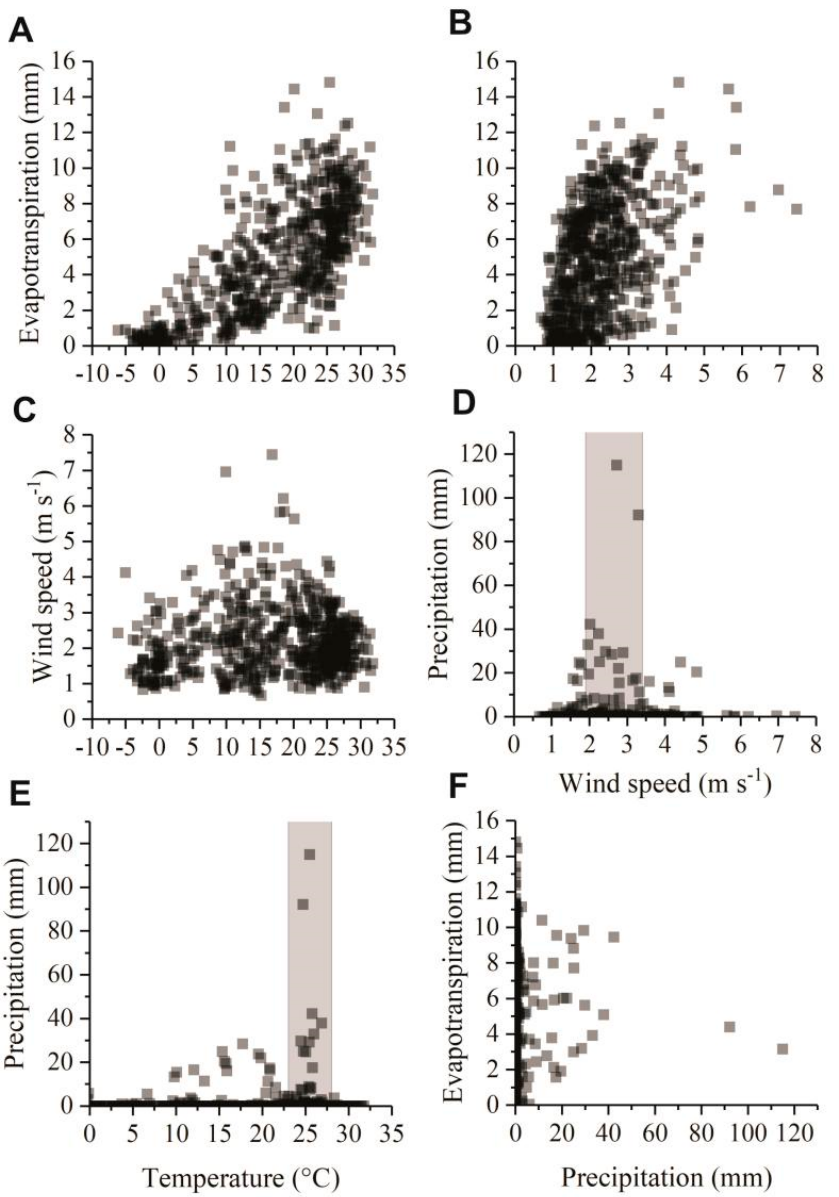
Figure 4. Relationships between every two meteorological factors of the daily timescale: ( A ) evapotranspiration and temperature, ( B ) evapotranspiration and wind speed, ( C ) wind speed and temperature, ( D ) precipitation and wind speed, ( E ) precipitation and temperature, ( F ) evapotranspiration and precipitation. The shaded parts on Figure 4D, E indicate the wind speed or temperature range corresponding to relatively higher precipitation.